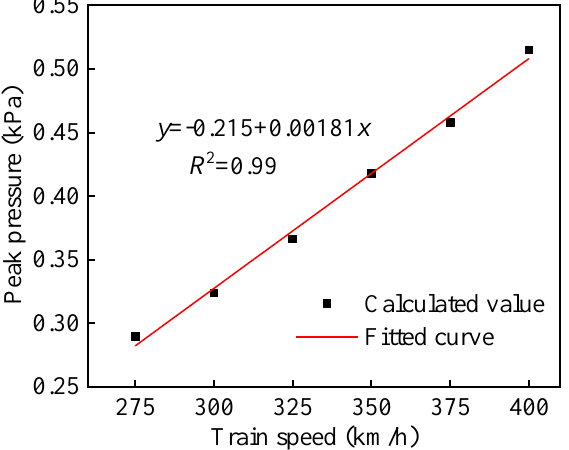
Figure 14. Peak pressure versus train speed of monitoring point 1-V in Stage I.